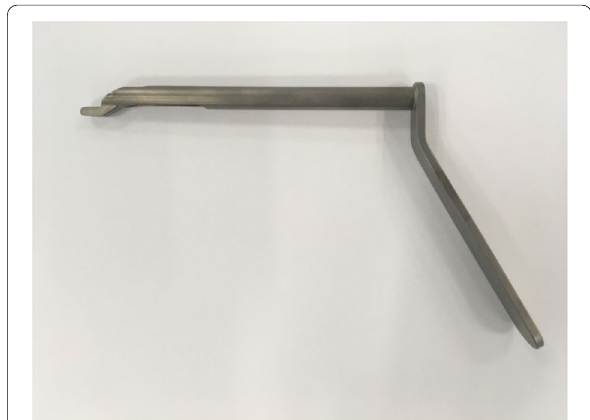
Fig. 2 Picture showing the specific cutting guide used in the second procedure